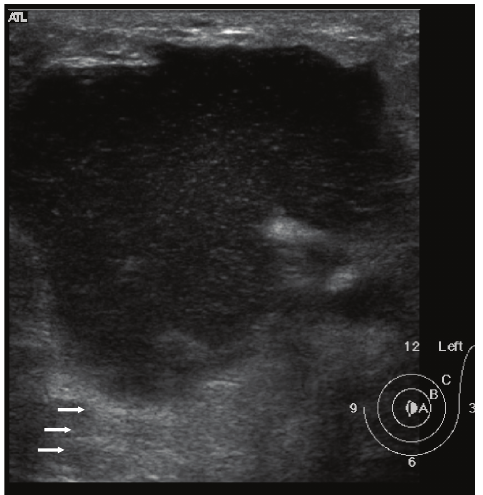
Figure 3: Abscess at presentation. The US image shows a relatively circumscribed hypoechoic area with internal echoes in retroareolar location. Posterior acoustic shadowing is also seen (arrows). It also demonstrated peripheral increased vascularity (not shown here), consistent with a breast abscess.